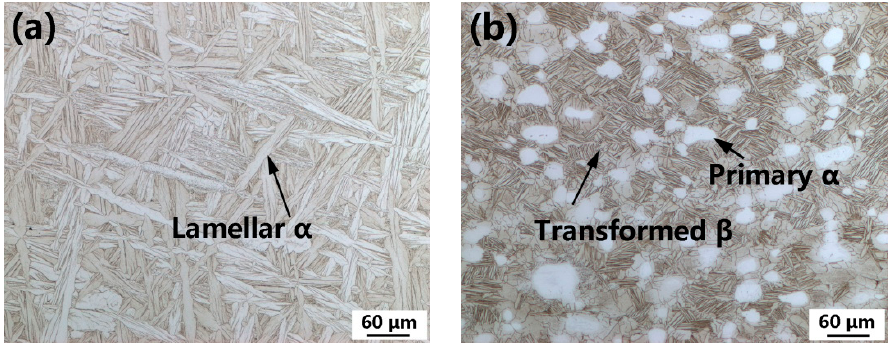
Figure 1. Wrought Ti60 alloy with lamellar ( a ) and bimodal ( b )